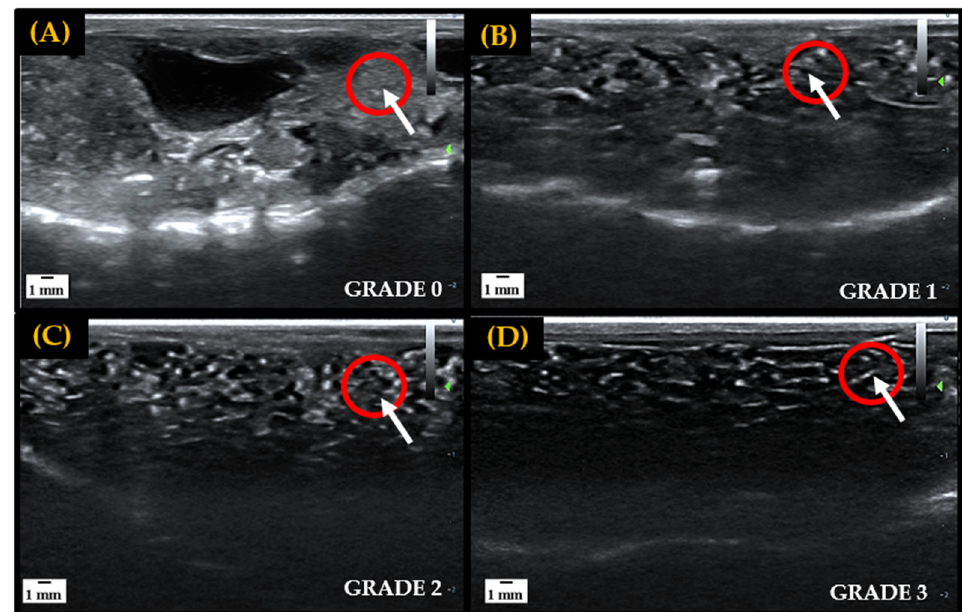
Figure 1. Representative ultrasound grading scale from 0 to 3 utilized to track and determine follicular maturity for breeding in female amphibians. Fluid, or egg jelly, is indicated by anechoic area (black), and hyperechoic areas (white) represent egg follicles, tissue, bones or other denser components. The red circles indicate the gradual maturation of follicles in a localized area. Panel ( A ): Large hyperechoic area indicates the absence of egg jelly surrounding follicles, signifying a lack of development—Grade 0. Panel ( B ): Increase in anechoic area, and slight separation of follicles, indicates the accumulation of egg jelly as follicles start to develop—Grade 1. Panel ( C ): Hyperechoic area is spread out and anechoic space begins to further separate follicles, indicating that more egg jelly is being recruited and follicles are developing—Grade 2. Panel ( D ): High density of anechoic area separating follicles indicates matured egg follicle—Grade 3.